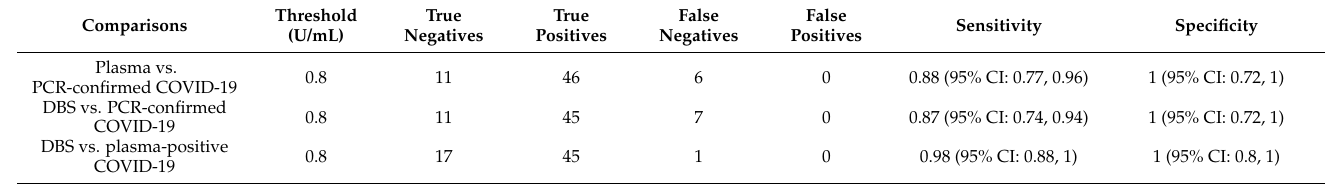
Figure 1. RBC mixed with plasma (1:1) were applied to filter cards, dried, and eluted. The sera and corresponding eluants were analyzed using Roche Elecsys Anti-SARS-CoV-2 (S) assay (plasma used for spiking RBC: n = 24 COVID-19-positive ( n = 23 serology positive) patients; n = 21 COVID-19-negative ( n = 22 serology negative) patients). The horizontal line indicates assay threshold as quoted by manufacturer for plasma/serum. ( A ) Distribution of values of DBS samples prepared from spiked RBC and corresponding plasma used for spiking for mismatched samples ( • ) and matched samples (o). ( B ) Dataset from ( A ) showing correlation between concentrations obtained from plasma vs. DBS. Table 1. Clinical performance of DBS vs. plasma for PCR-confirmed COVID-19